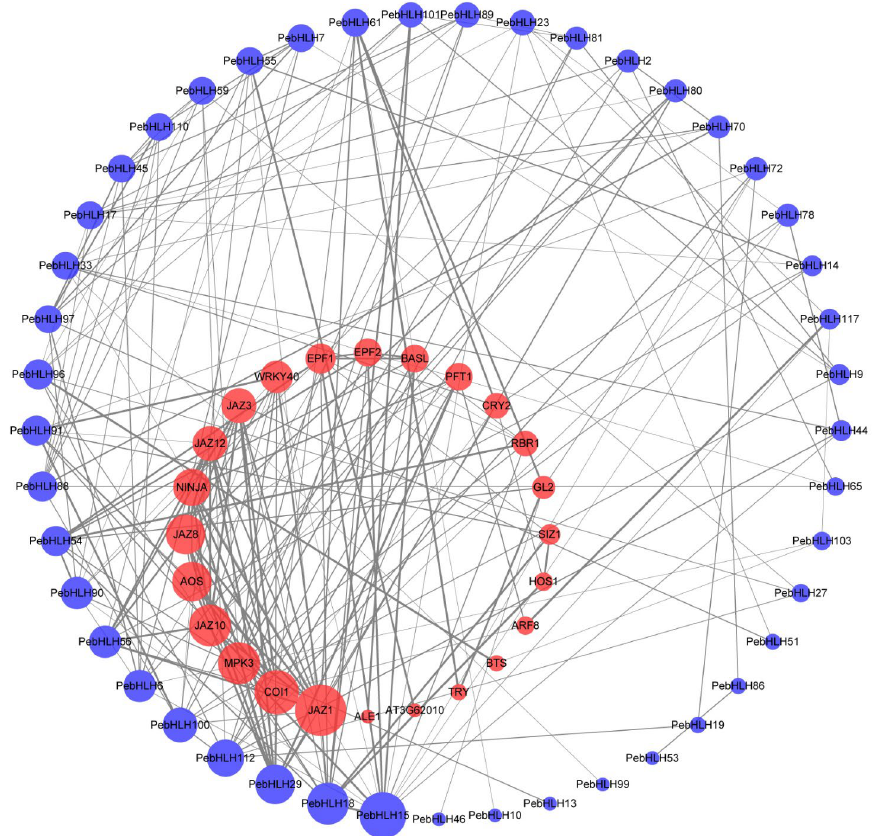
Figure 5. Protein interaction networks prediction of PebHLH. The outer blue circles indicate PebHLH proteins, and the inner red circles indicate other proteins in the reciprocal relationship. Interacting relationships are indicated by straight gray lines.